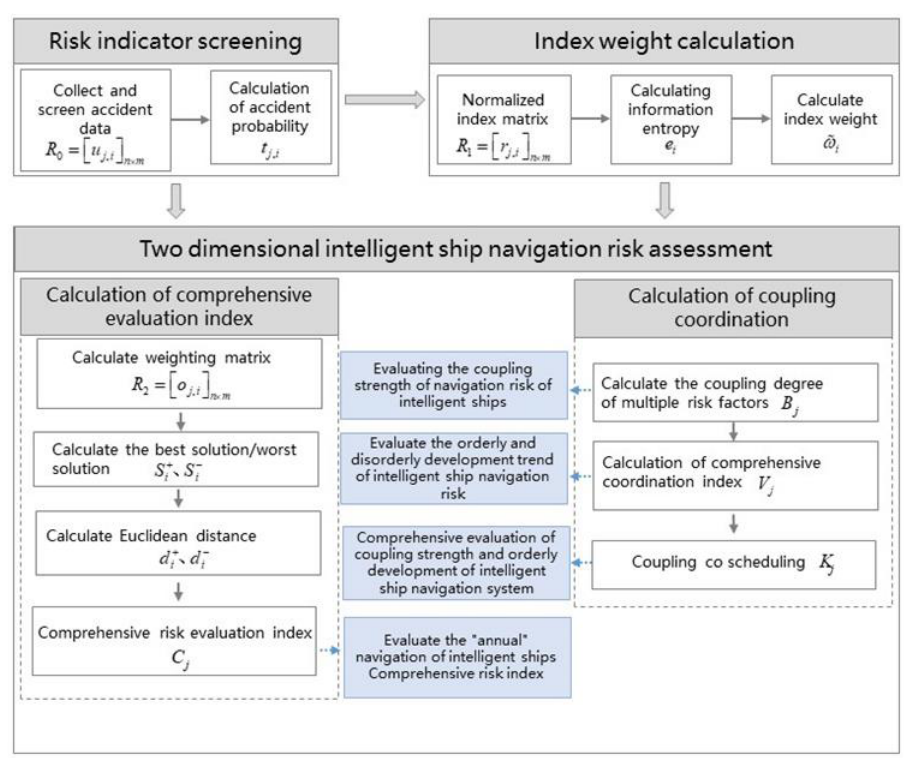
Figure 1. Calculation process of the Entropy – TOPSIS – Coupling coordination model.